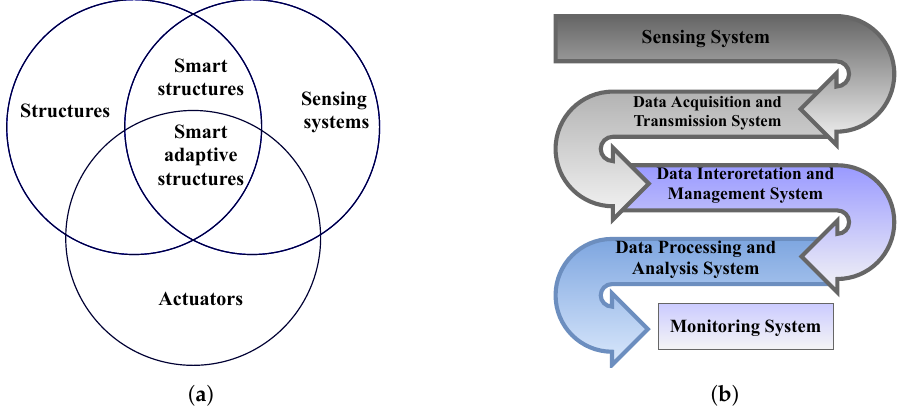
Figure 7. ( a ) Smart structures and smart adaptive structures, and ( b ) implementation of structural health